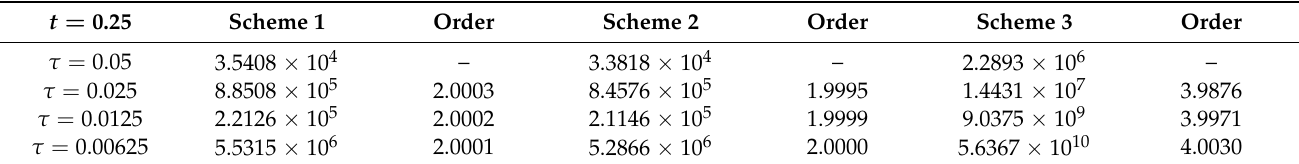
Table 1. The L ∞ errors and the order of convergence of three different schemes with h = 0.16 and different time steps at t =